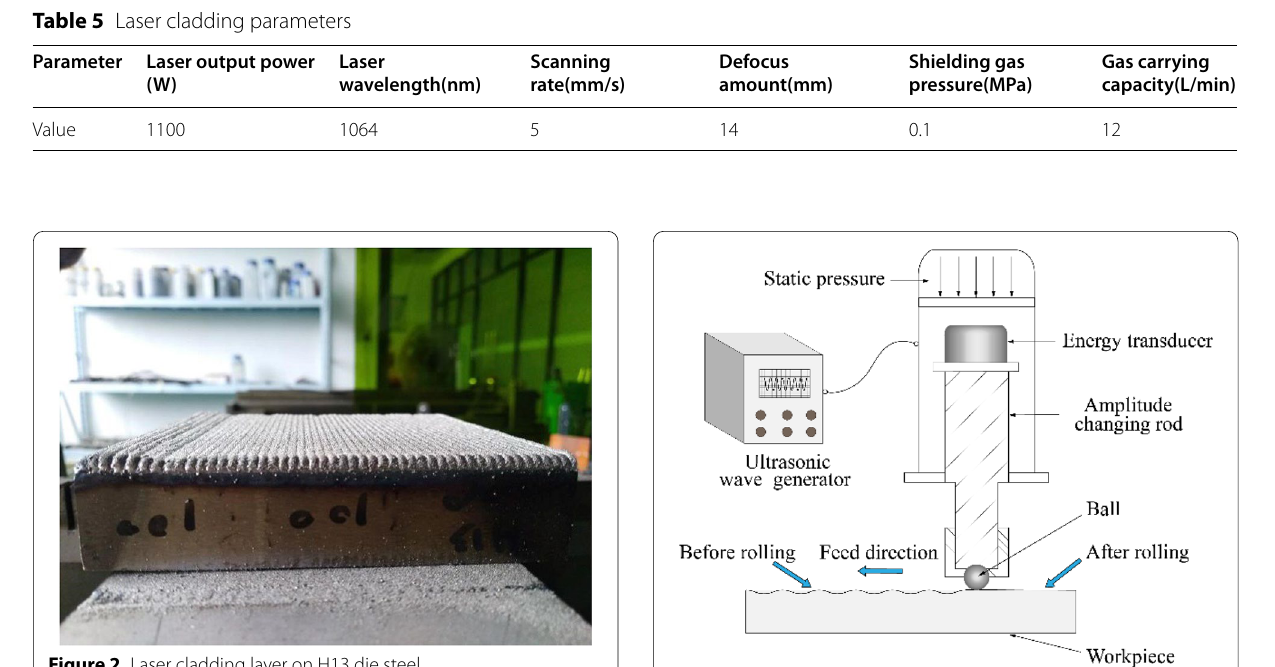
Figure 2 Laser cladding layer on H13 die steel